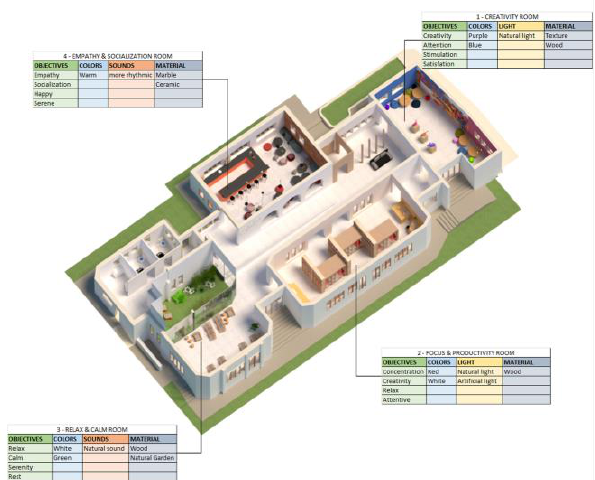
Figure 2 Project outline: objectives, colours, sounds, lights and materials